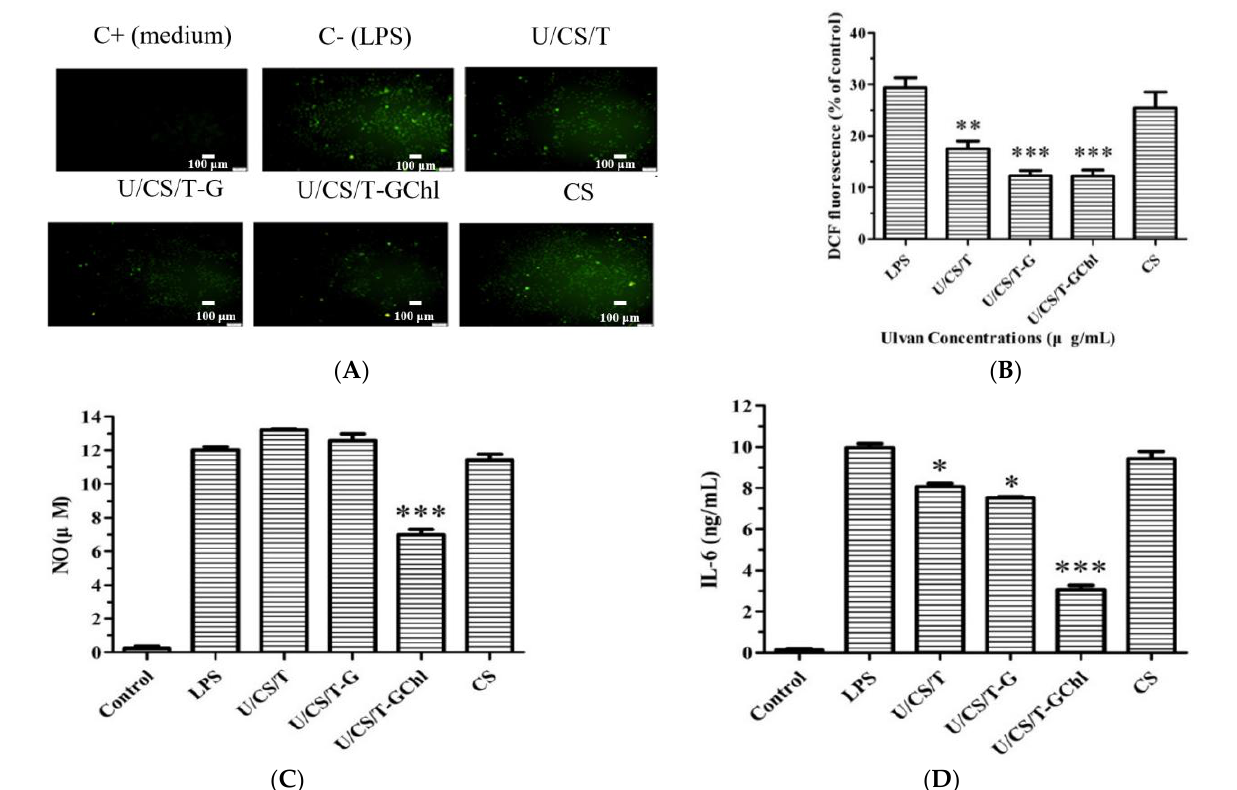
Figure 7. ( A ) Inverted fluorescence microscopic images, ( B ) flow cytometry analysis of intracellular production of ROS, and secretion of ( C ) NO and ( D ) IL-6 in LPS-stimulated RAW264.7 cells cultured in various released media of the ulvan/chitosan complex films. Data represent mean ± SD from 3 separate. Control is the medium without LPS. * p < 0.05, ** p < 0.01, *** p < 0.001 compared with the control group